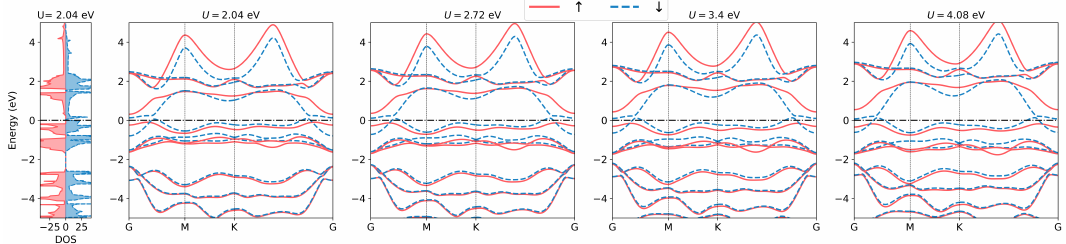
Figure 8: DOS and band structure of majority and minority spins for monolayer LiCoO for various values of 2